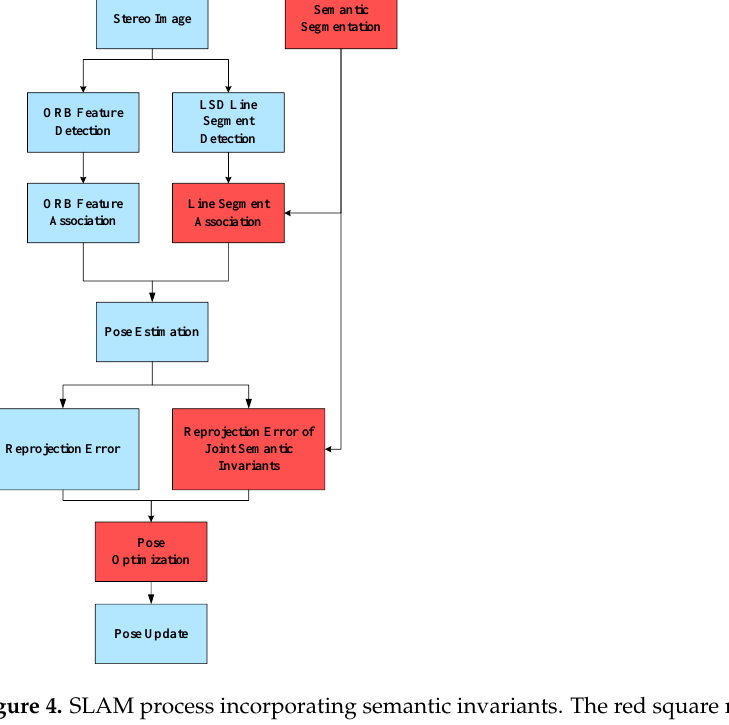
Figure 4. SLAM process incorporating semantic invariants. The red square represents the effective area of the semantic segmentation result. We use semantic invariants as conditional constraint for the data association between line features, and define an error function fused with semantic invariants to optimize the